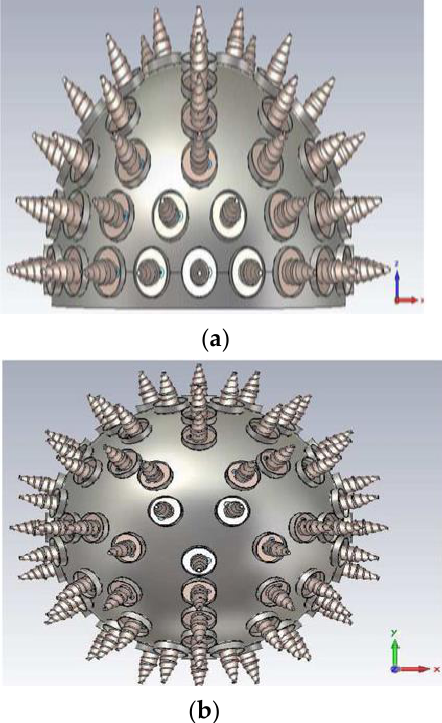
Figure 1. SAA with 64 elements as modeled with CST: ( a ) side view and ( b ) top view [3]. A linear array that scans in one axis, and a planar array that scans in the x- and y- axes, are acceptable for a bounded scan demand of 60 – 70 ° [3]. The projected apertures of these arrays drop by the cosine factor of the scan angle. Hence, the array directivity is reduced for a big scan angle. For larger steerability, a multifold planar configuration, or in a general form, an SAA is preferred [3 – 5]. The directivity of an SAA remains almost the same when an active source is moved over the surface of the